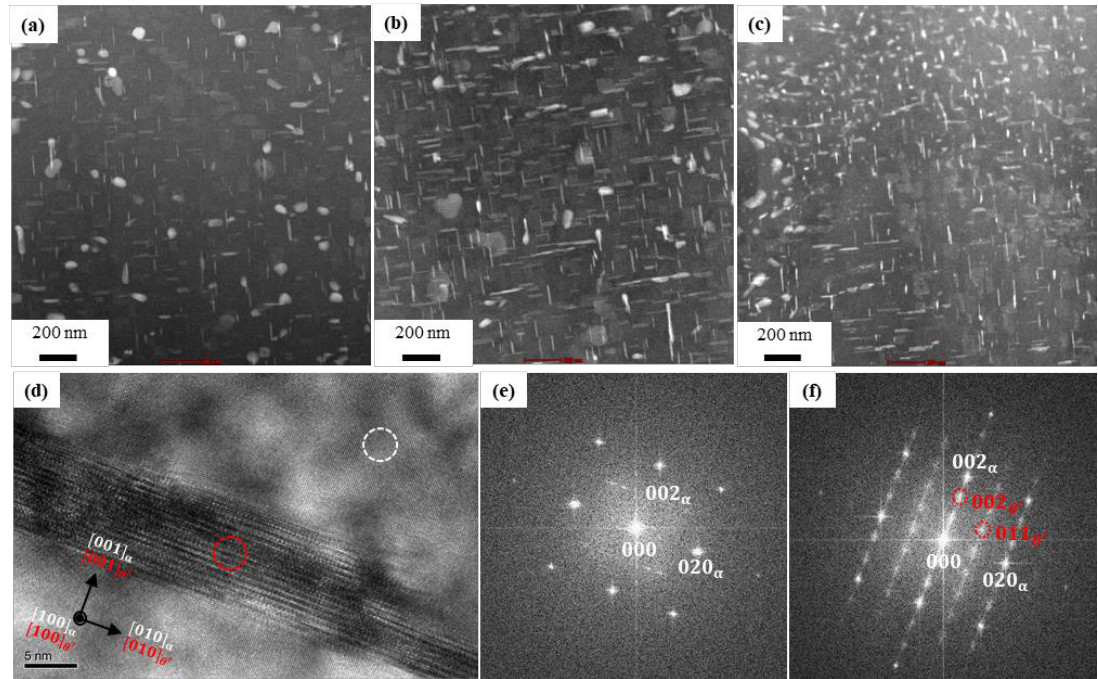
Figure 8. Transmission electron microscope (TEM) image of Al-XSi-3Cu-0.6Mg-0.5Fe [X = ( a ): 10, ( b ): 12.6; ( c ): 14] T6 heat-treated extruded bars; ( d ) high-resolution TEM (HRTEM) image of θ ′ -Al 2 Cu phase. Fast Fourier transform pattern of the ( e ) white and ( f ) red circles displayed in the HRTEM image shown in ( d ).